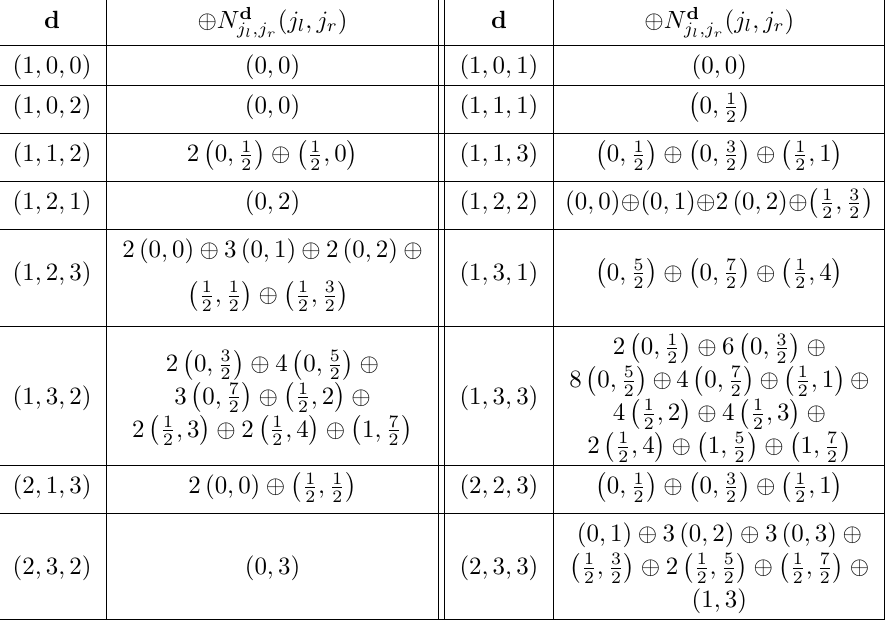
Table 27. BPS spectrum of P 2 ∪ F 3 + 1 Sym for d 1 ≤ 2 , d 2 , d 3 ≤ 3 . Here, d = ( d 1 , d 2 , d 3 ) labels the BPS state with charge d 1 ( ˜ m − 2˜ φ 2 ) + d 2 (3˜ φ 1 − ˜ φ 2 ) + d 3 ( − ˜ φ 1 + 2˜ φ 2 ) . The d 1 = 0 sector is the same with that of P 2 ∪ F 3